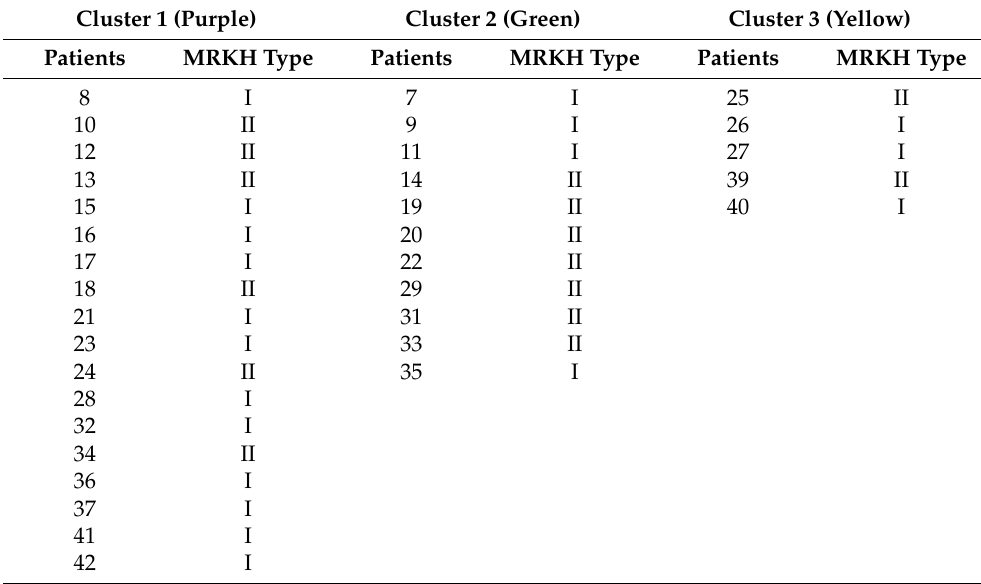
Table 1. Phenotype of MRKH patients included in the graphical illustration of PCA